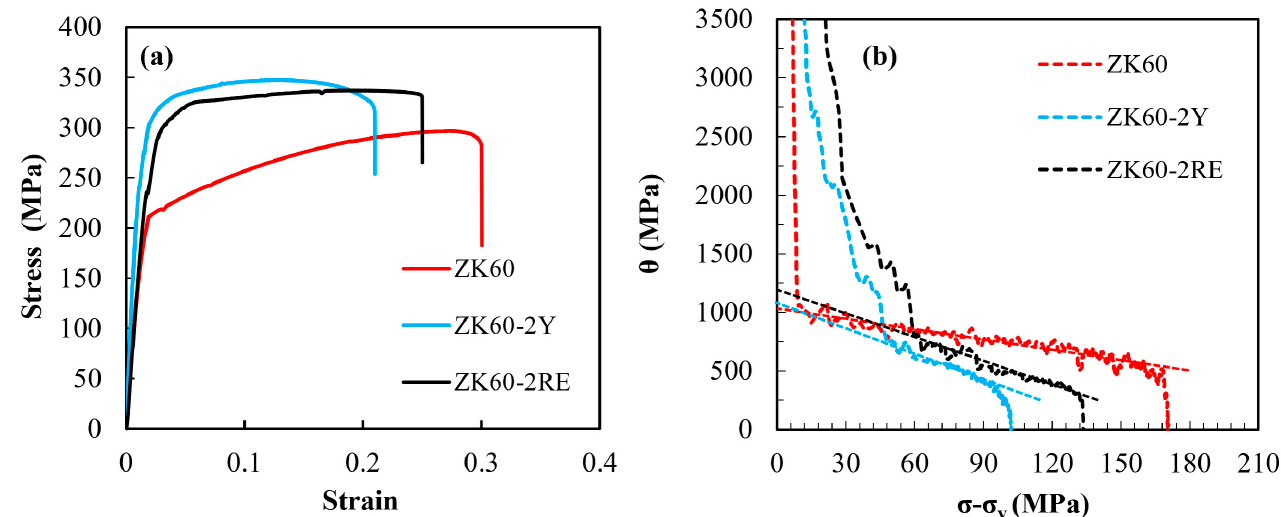
Figure 6. ( a ) Tensile engineering stress–strain curves and ( b ) work hardening curves. The lines fitted on the hardening curve in stage III were used for the determination of the values of 𝜃 (cid:2868) (cid:3010)(cid:3010)(cid:3010) and σ s for the three studied alloys.